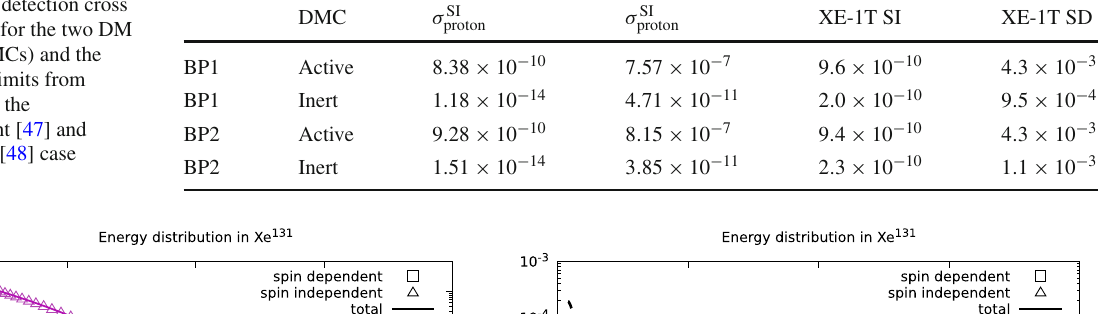
tom) Ratio of active plus inert neutralino (solid) and active neutralino only (dotted) signal rates to the total background ones as obtained from the top plot. In addition, a detailed view of the difference in linear scale is also displayed